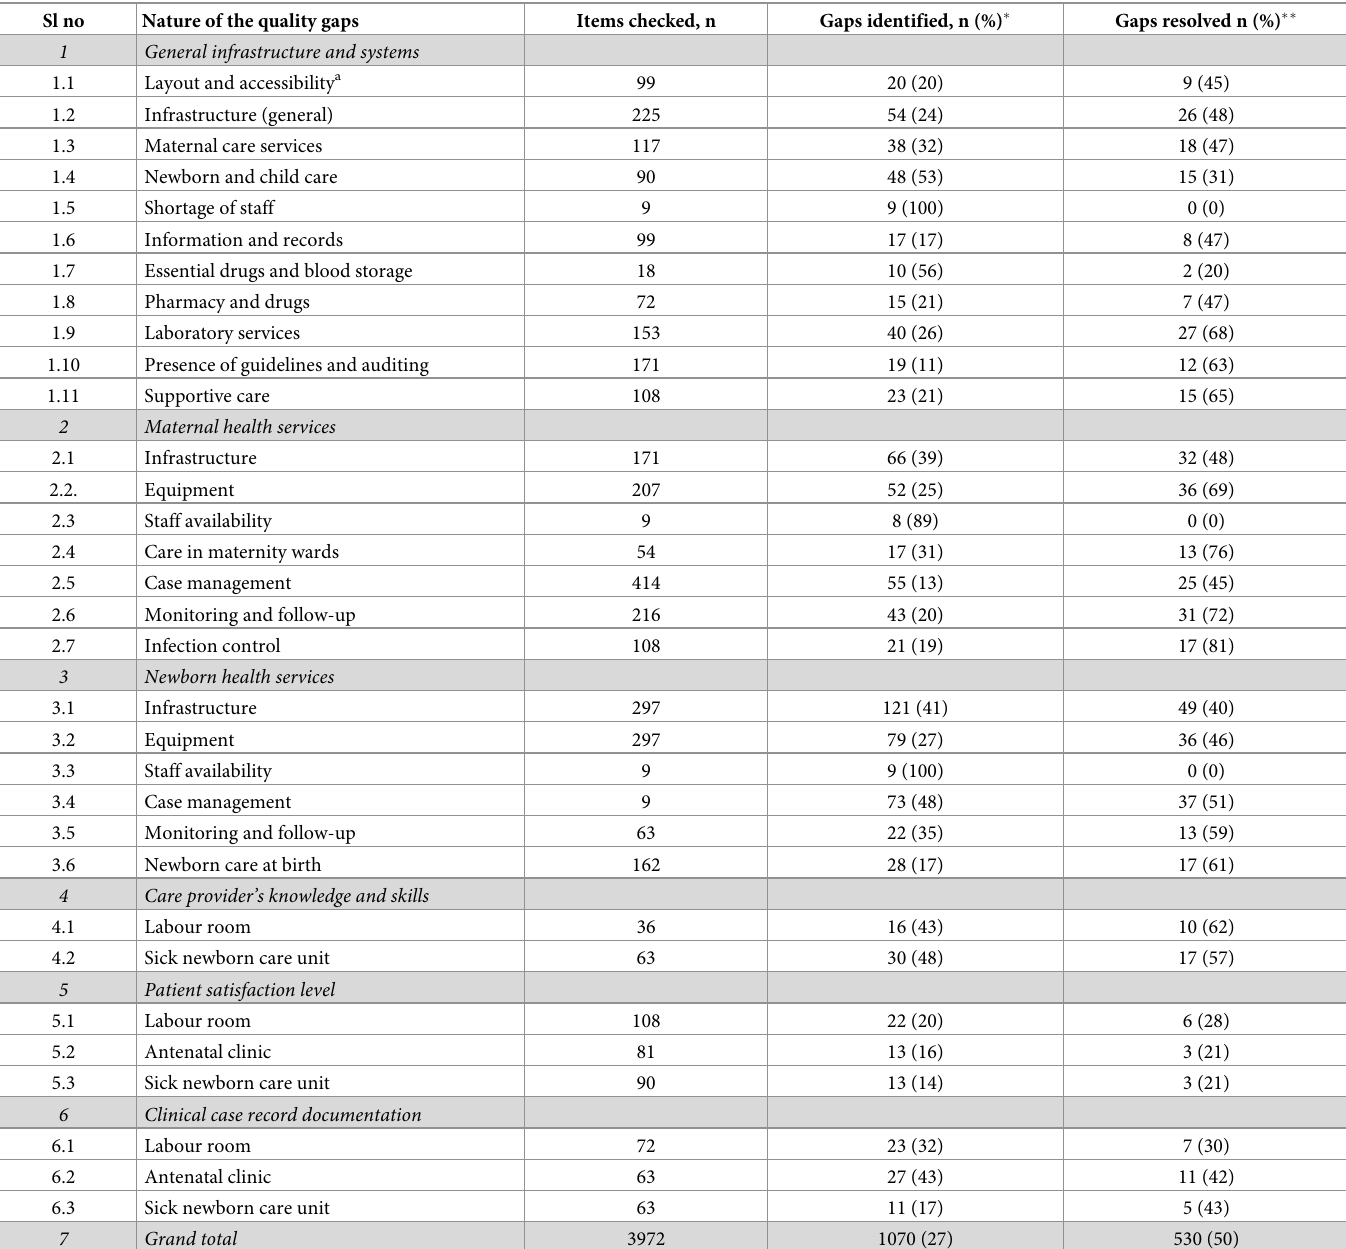
Table 1. The quality gaps identified and resolved during the intervention (all districts